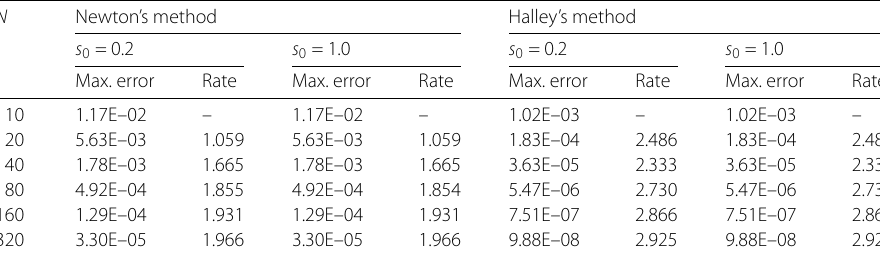
Table 2 Pointwise absolute errors in the maximum norm and computed rates of convergence versus the number of sub-intervals N with s 0 = 0.2,1.0 for each in Example 4.1. We set α 1 = 0.4, α 2 = 1.7, and m is fixed at 10 N Newton’s method Halley’s method s 0 = 0.2 s 0 = 1.0 s 0 = 0.2 s 0 = 1.0 Max. error Rate Max. error Rate Max. error Rate Max. error Rate 10 1.17E–02 –